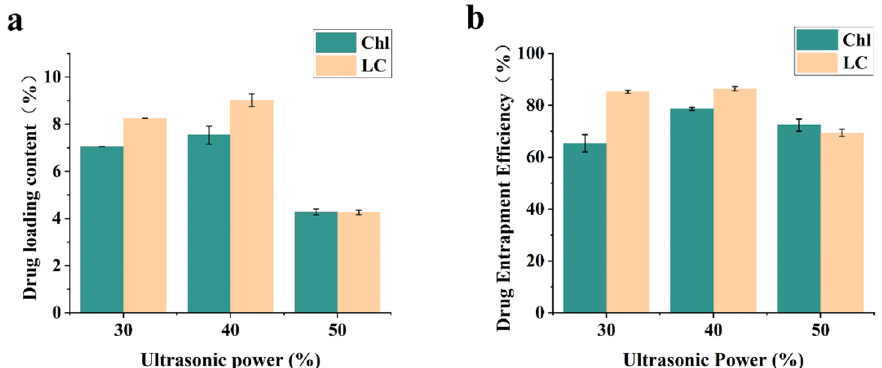
Figure 4. ( a ) Drug loading contents and ( b ) encapsulation efficiencies for chlorantraniliprole (Chl) and lambda cyhalothrin (LC) at different ultrasonic emulsification powers.